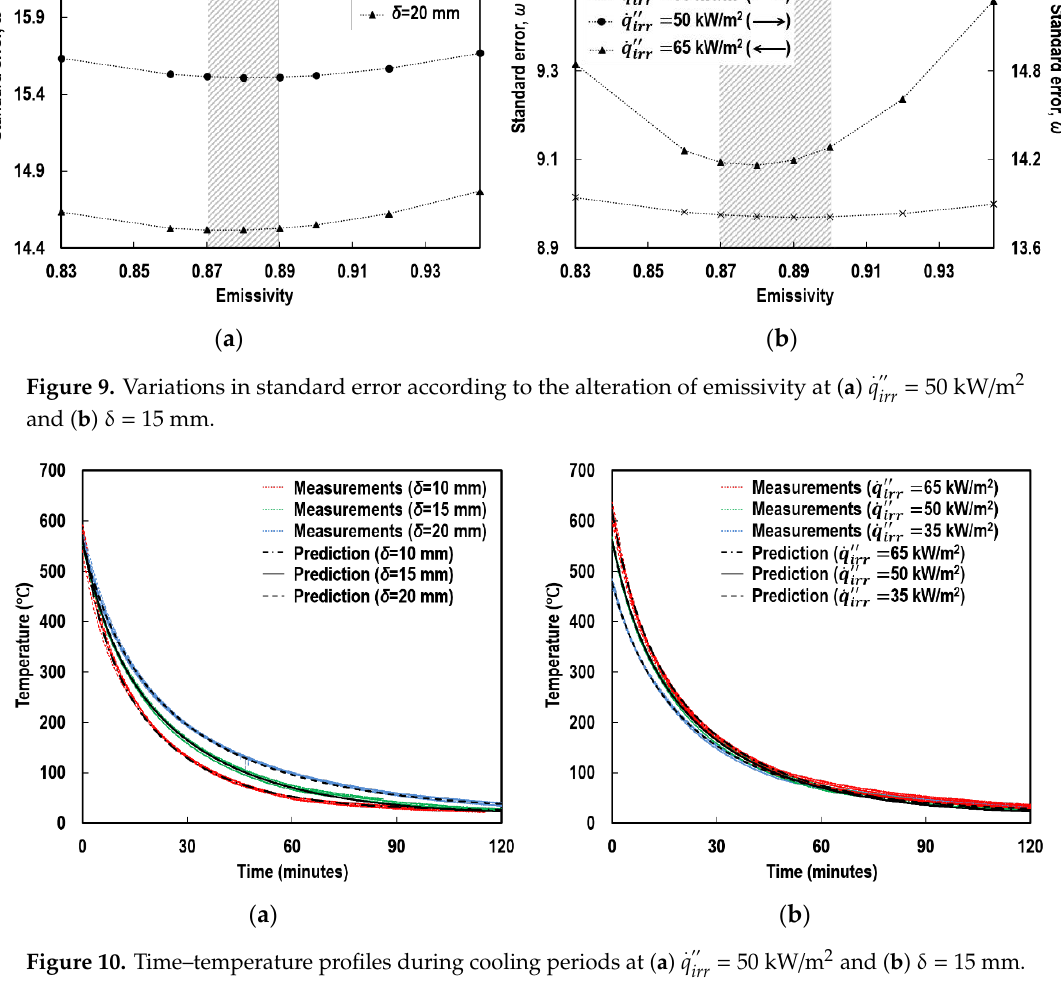
Figure 10. Time–temperature profiles during cooling periods at ( a ) 𝑞̇ 𝑖𝑟𝑟′′ = 50 kW/m 2 and ( b ) δ = 15 mm.